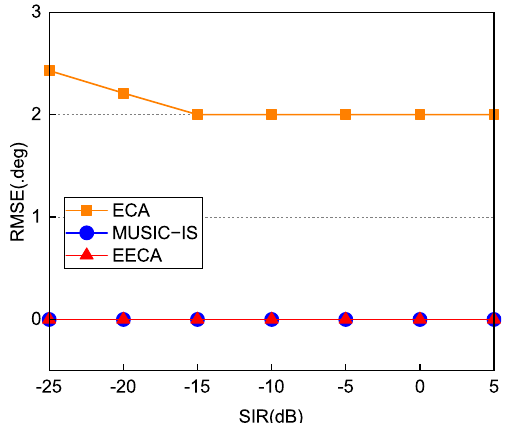
Figure 6. Comparison of RMSE versus SIR curves among the ECA, MUSIC-IS, and EECA in Scenario